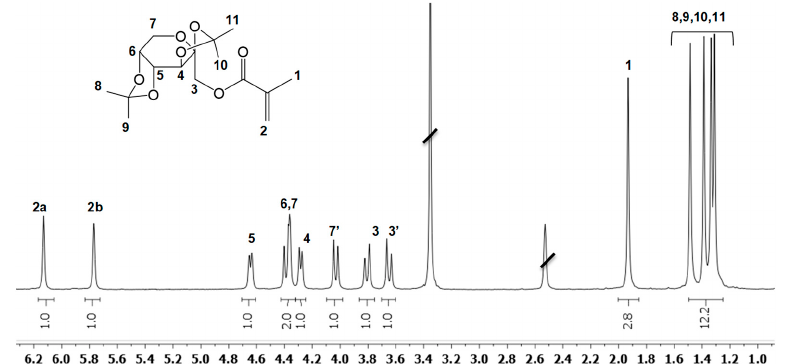
Figure 1. 1 H-NMR spectrum of the methacrylate protected fructose (MF) monomer in DMSO- d 6 .